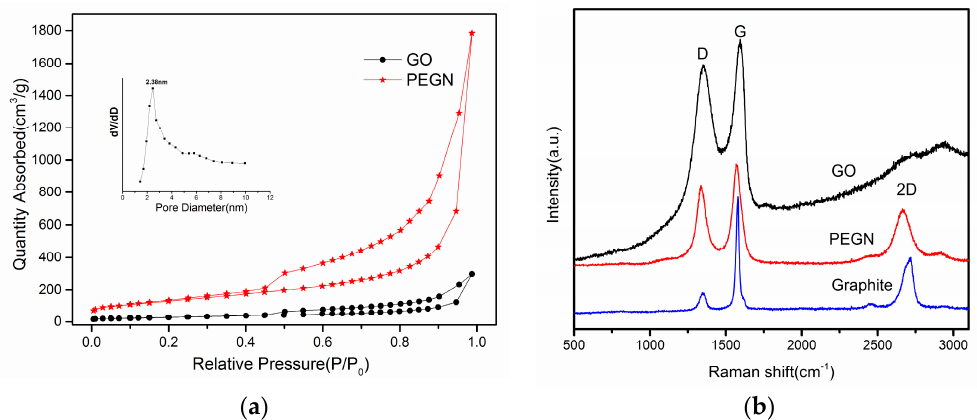
( h ) Figure 2. ( a ) Schematic representation of exfoliation and reduction of GO using DBD plasma technology; SEM images of ( b ) GO and ( c ) plasma-exfoliated graphene (PEGN); ( d ) TEM and ( e ) HRTEM images of PEGN; ( f ) selected area electron diffraction (SAED) pattern indicating a disruption of long-range ordering in graphene; ( g ) atomic force microscopy (AFM) images of PEGN (scale bar = 500 nm). ( h ) Height profiles along line in ( f ). Then, we further characterized the GO and PEGN from the N 2 adsorption and desorption isotherms (3Flex, MicroMetric Inc., Sarasota, FL, USA) at 77 K. It was observed that the S BET value of the PEGN was 475 m 2 /g, while that of the GO was 101.5 m 2 /g. The larger specific surface area was advantageous to the formation of a conductive network. Figure 3a shows that the isotherms were of type-IV with H 2 hysteresis loops at relatively high pressures. This indicated that these materials consist of aggregated sheets in which there are typical mesoporous microstructures, while the pore size was found to be approximately 2.38 nm (inset, Figure 3a). The Raman spectra of GO, graphite, and PEGN are shown in Figure 3b. These three spectra all exhibit a D and G band. The G band of PEGN shifted to 1591 cm − 1 while that of GO was at 1598 cm − 1 , approximating to the value of pristine graphite, which suggests that the GO was reduced through the plasma treatment. The D band for both GO and PEGN overtopped that of pristine graphite, predicting the presence of defects in the sample and the size of the in-plane sp 2 domain. The intensity ratio ID/IG of the D and G bands varied